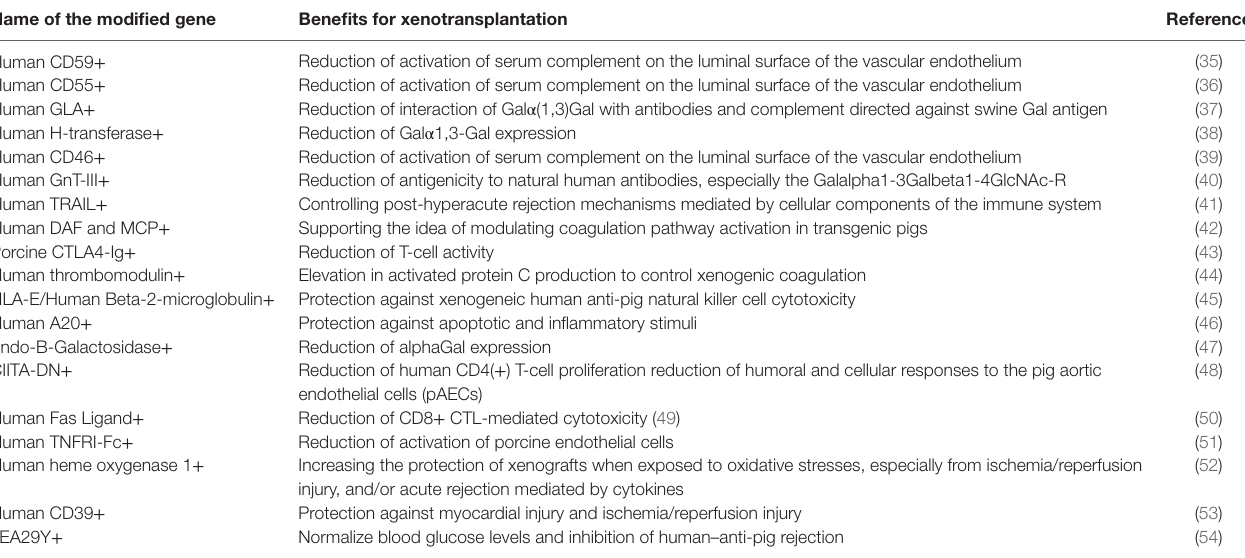
TABLe 2 | The potential genes for CRISPR